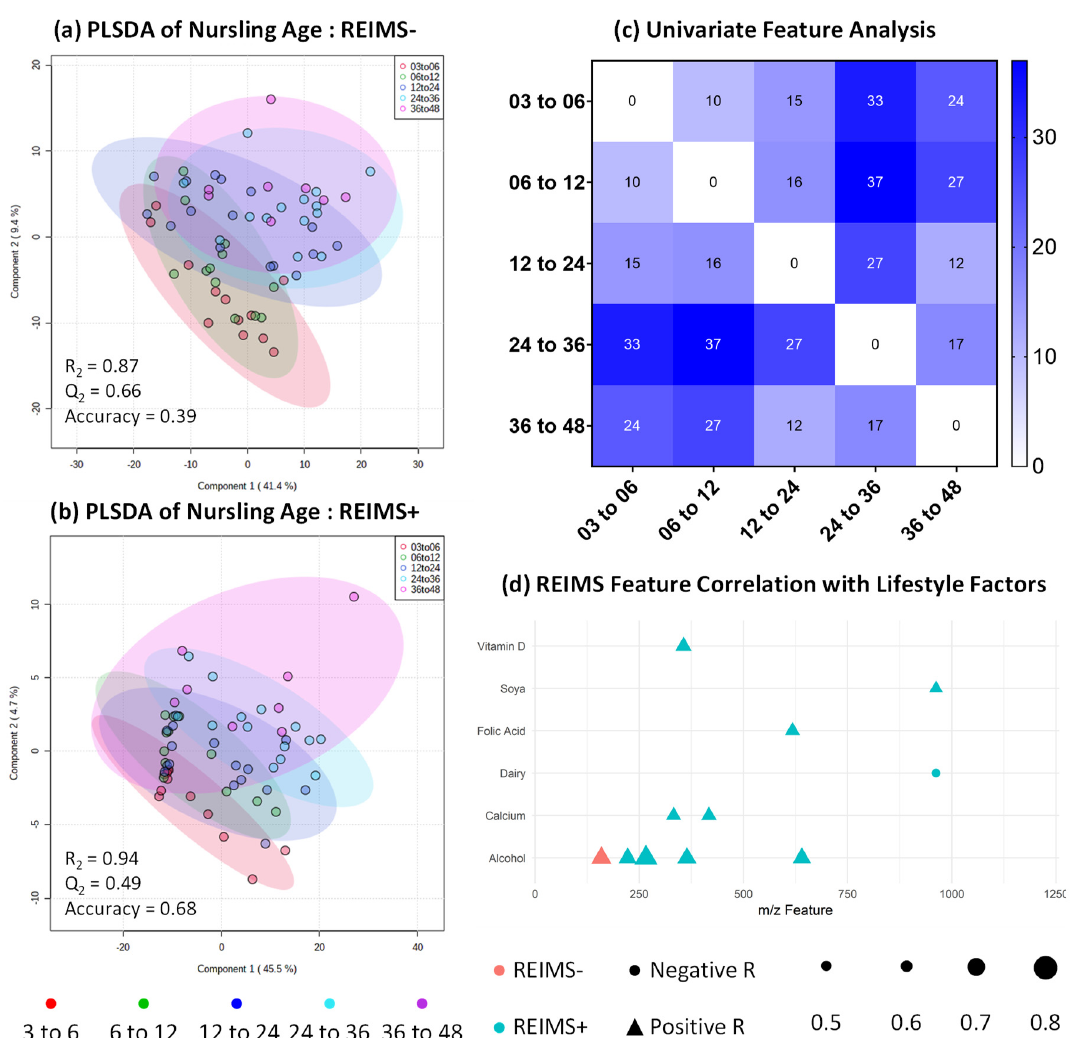
Figure 4. Significantly different univariate components identified in negative ion detection mode. Partial least squares-discriminant analysis (PLS-DA) modelling of nursling age for both ( a ) negative ion detection and ( b ) positive ion detection modes show no significant separation, but ( c ) univariate ANOVA shows significant (False discover rate (FDR) corrected p value below 0.05) differences for nursling age between defined age groups, across both rapid evaporative ionisation mass spectrometry (REIMS) ion detection modes, with the greatest identifiable differences between age groups either side of 24 months. Further analysis of ( d ) Pearson’s correlation coefficient analysis against reported lifestyle factors shows several significant correlating features with a p value threshold of below 0.05 and correlation coefficient cut-off of above 0.5 for positive correlations or below − 0.5 for negative correlations. Colour coding indicates REIMS ion detection modality. Data point shape indicates whether correlation coefficient is positive or negative and size indicates strength of correlation coefficient. A total of 62 human milk replicates were used.